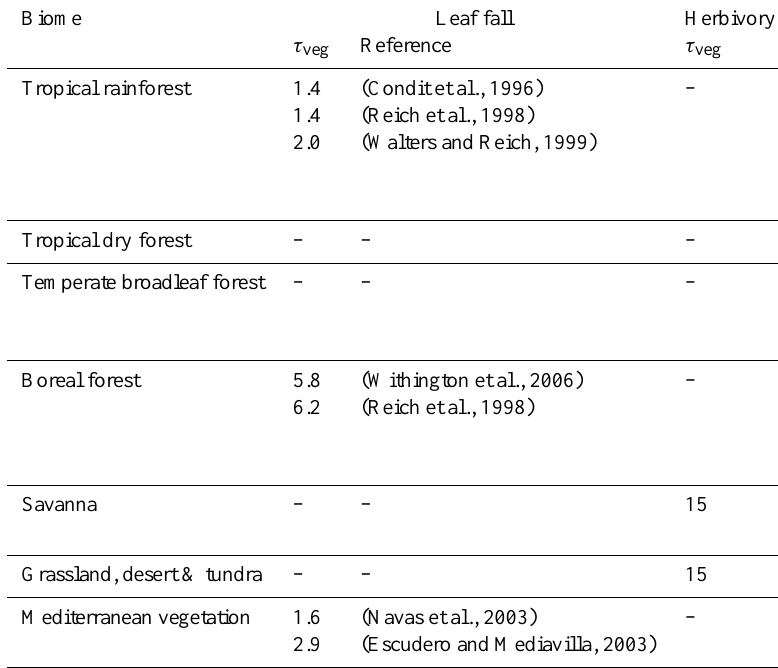
Table B5. References for the disturbance intervals τ veg [years] of different biomes regarding leaf fall and herbivory. A “–” means that the corresponding type of disturbance probably does not play a significant role for lichens and bryophytes living in the biome. The value for herbivory was estimated by best guess due to lack of